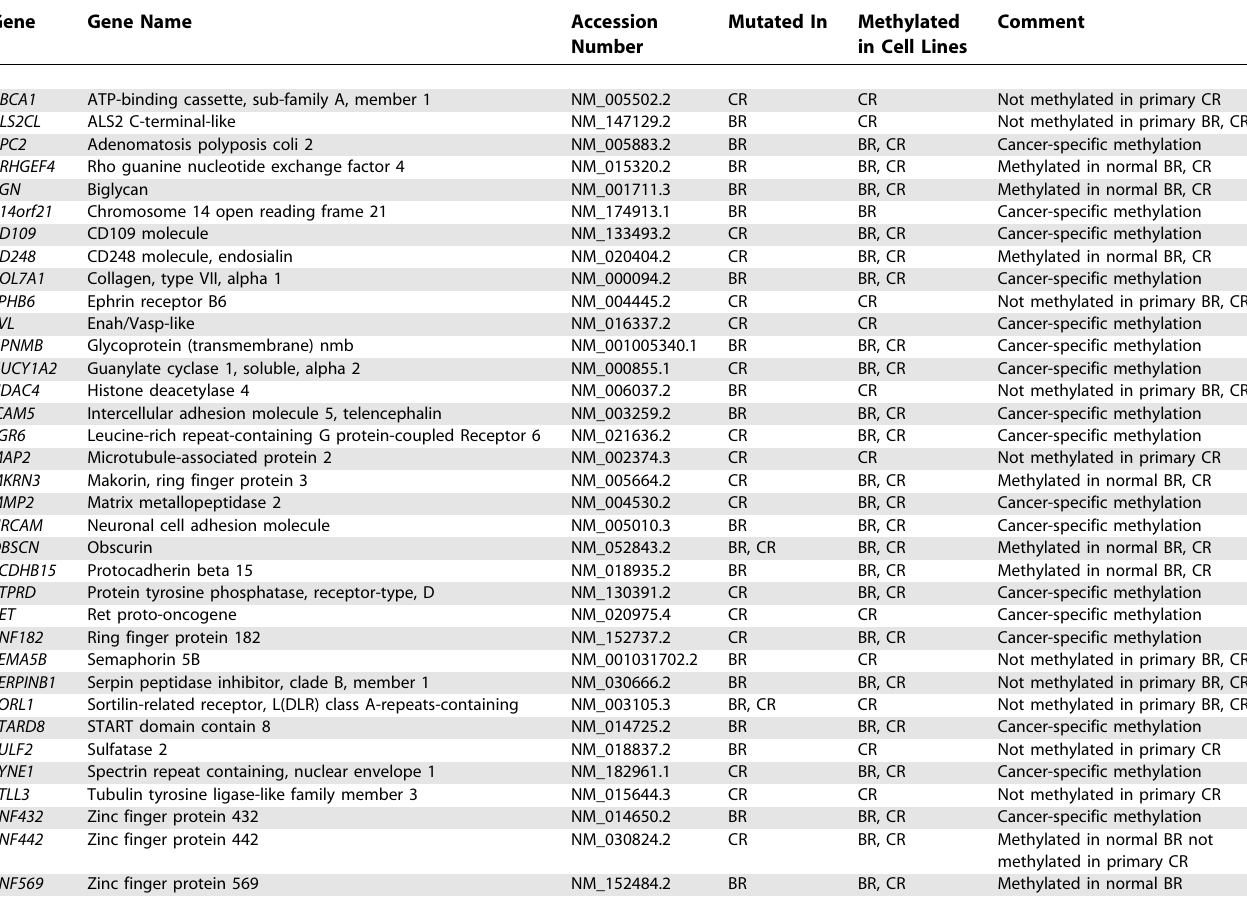
Table 1. Genes Targeted by Mutation and